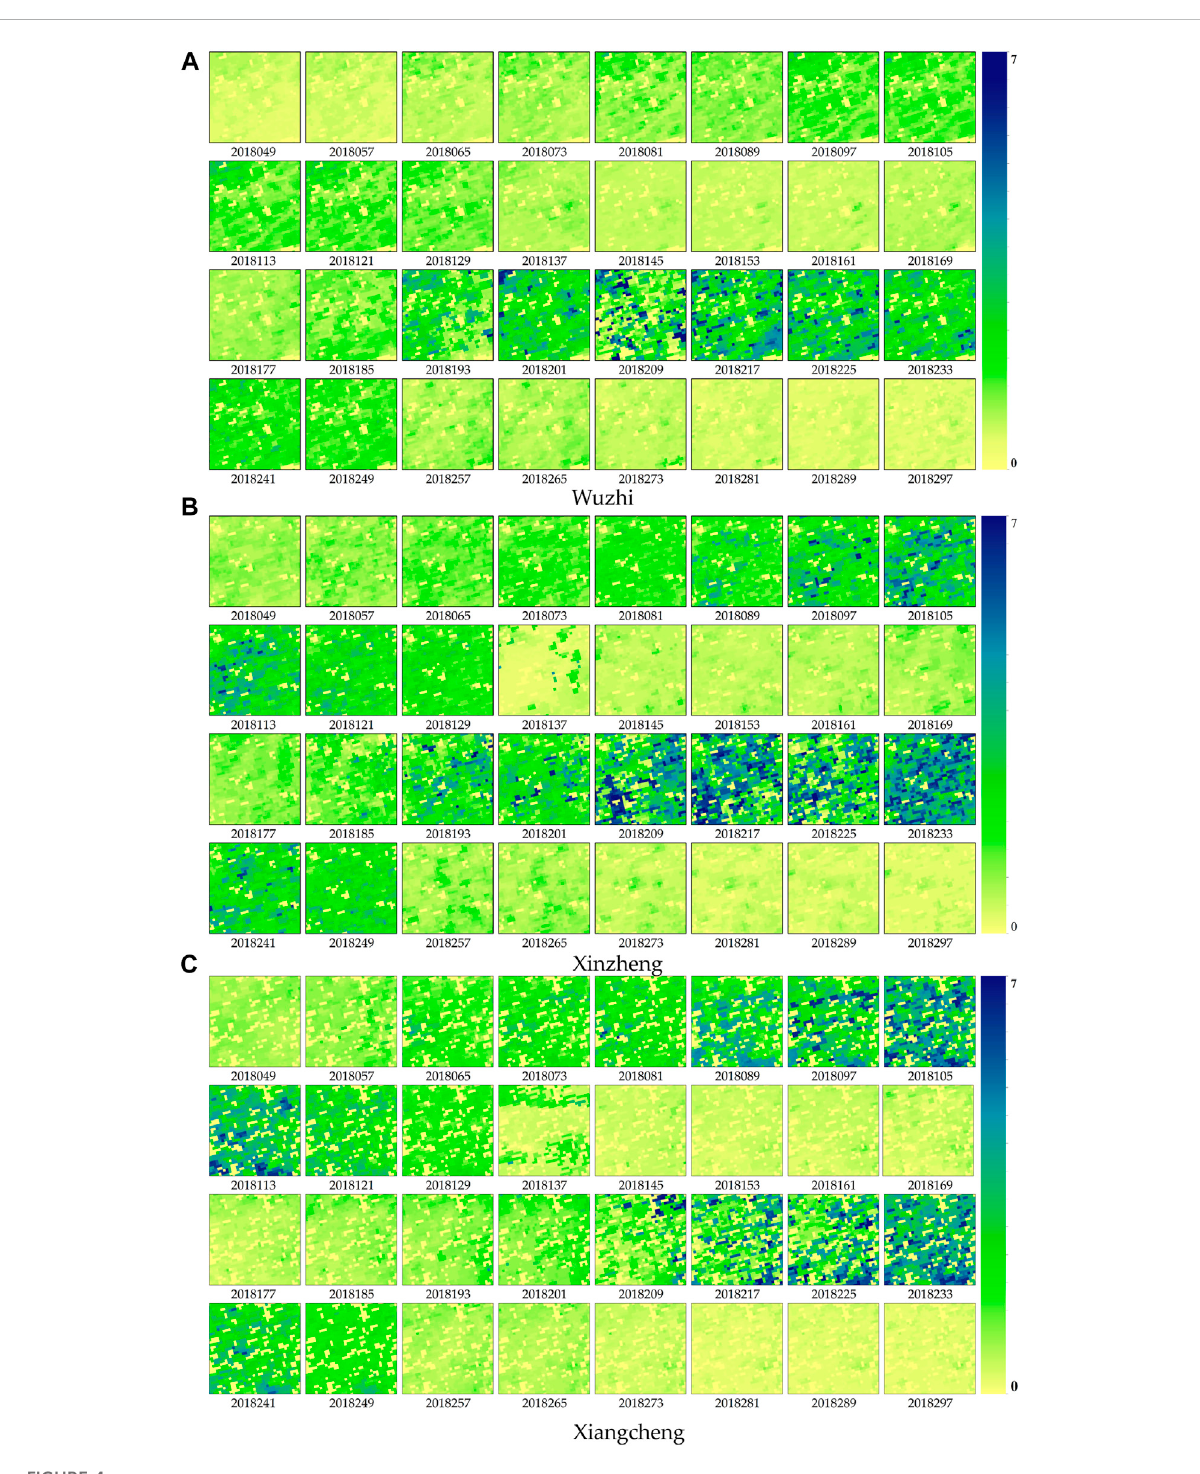
FIGURE 4 NARXNN improved the time series LAI in (A) Wuzhi, (B) Xinzheng, and (C) Xiangcheng in 2018. The color bar beside each sub-image indicates the corresponding LAI values for different colors. All three LAI maps are marked with the corresponding day of the year (DOY) from 49 to